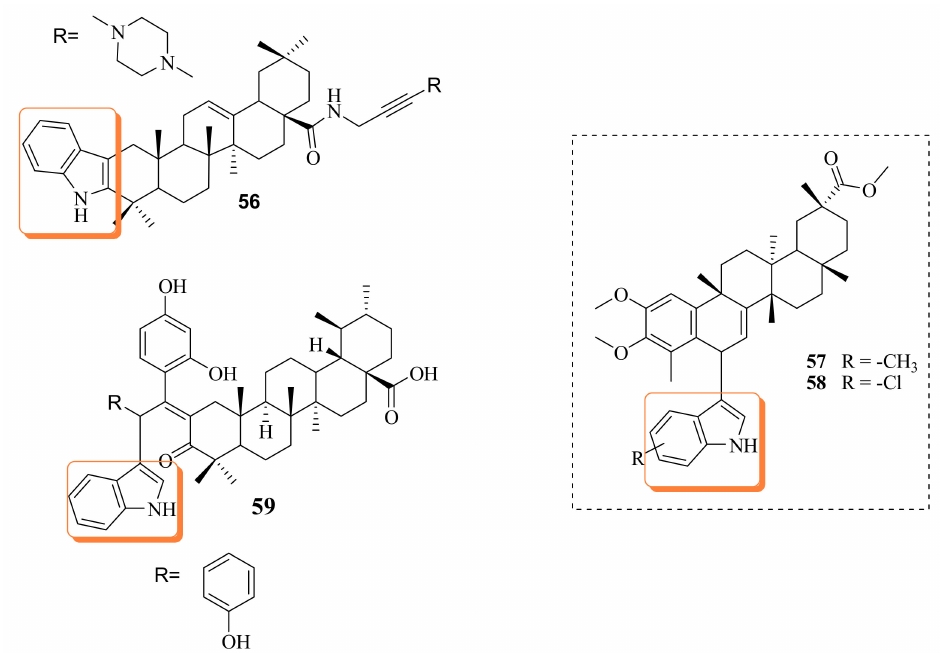
Figure 5. Oleanolic and ursolic acid-based indole